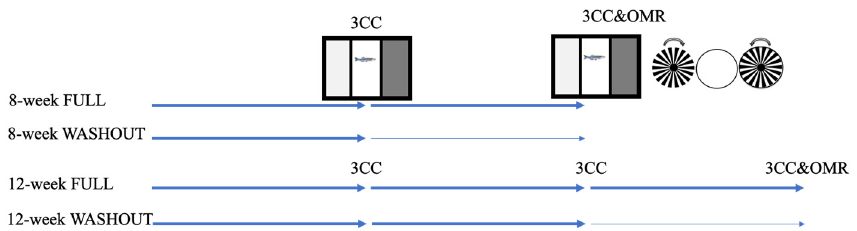
Figure 12. Experimental design. Using the alternating, increasing immersion protocol, hyperglycemia was induced in adult zebrafish for either 8 weeks (8-week FULL) or 12 weeks (12-week FULL). To assess the effect of recovery, additional experiments were performed in which the fish were hyperglycemic for 4 weeks, followed by 4 weeks removed from treatment (8-week WASHOUT) or hyperglycemic for 8 weeks, followed by 4 weeks removed from treatment (12-week WASHOUT). Each arrow in the above figure represents 4 weeks; darker arrows reflect treatment exposure, and thin arrows represent recovery. At each 4-week timepoint, cognitive behavior was assessed using the three-chamber choice task (3CC). At 8 weeks and 12 weeks, optomotor responses (OMRs) were also recorded.